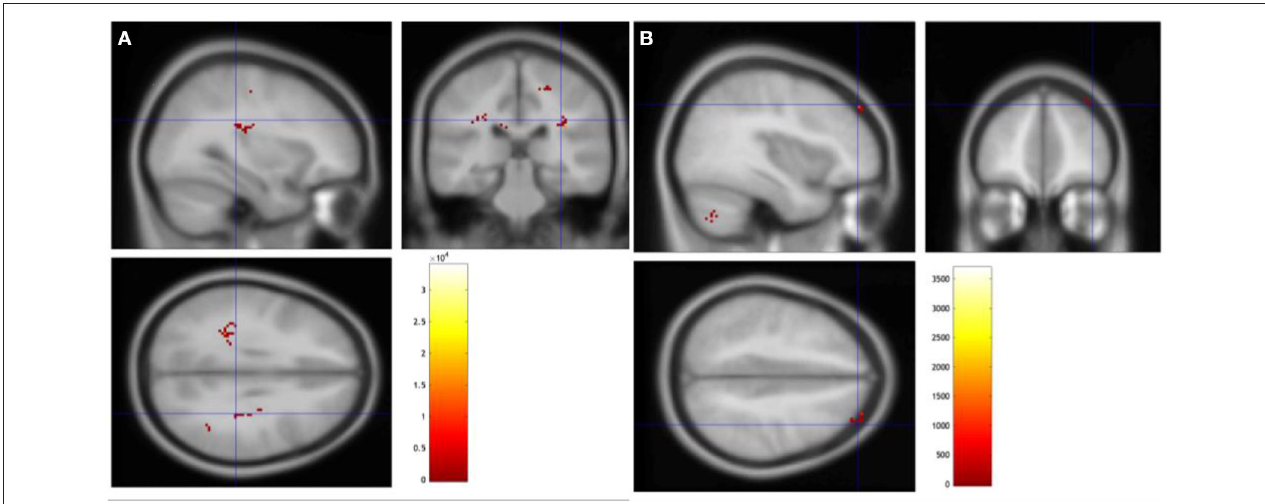
FIGURE 1 | Changes in fMRI during language sentence completion task. (A) Change in patient no. 3. (B) Change in patient no.